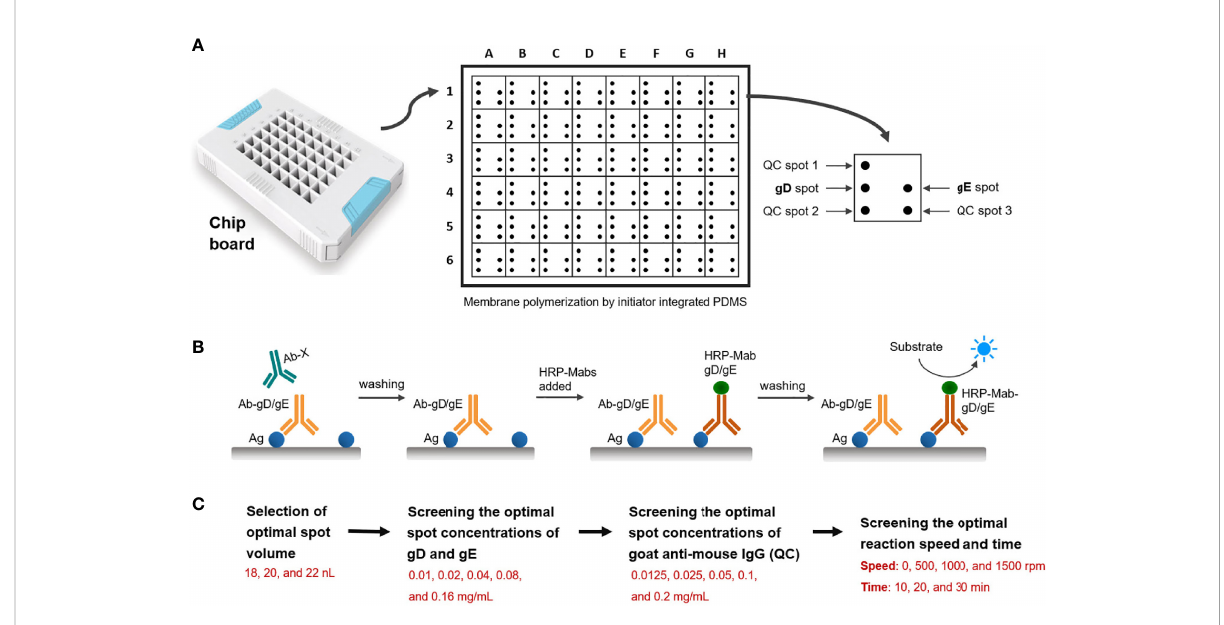
FIGURE 1 Schematic diagram of the design of the double Abs detection system. (A) Spotting design of detection points in the hole of the chip board. QC, quality control. (B) Schematic diagram of the steps of the blocking ELISA method for PRV gD and gE Abs detection. Ag: gD or gE coated in the membrane. Ab-gD/gE: PRV gD- or gE-speci fi c Ab in serum samples. Ab-X: PRV gD- or gE-non-speci fi c Ab in serum samples. HRP-Mab-gD/gE: HRP-labeled Mabs of PRV gD or gE in the blocking assay. (C) Screening process for the reaction conditions of the detection system, including the optimal spot volume, spot concentrations of gD, gE and goat anti-mouse IgG, and reaction speed and